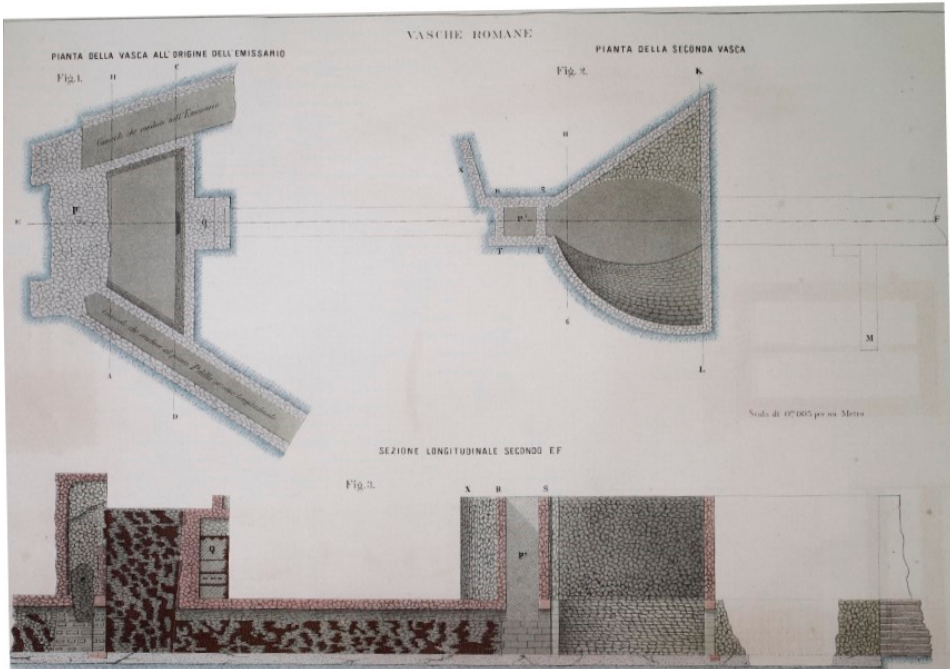
Figure 2. Plan and longitudinal section of the Roman incile by A. Brisse and L. De Rotrou [3].